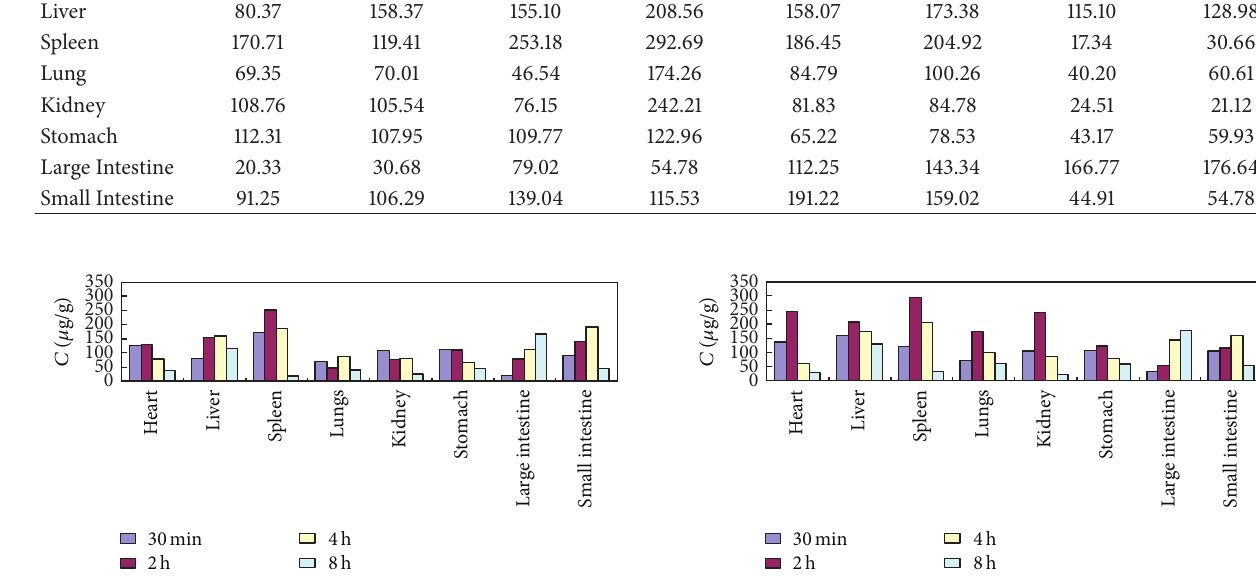
Figure 5: The concentration-time profile of (4 E ,6 E ,12 E )- tetradecatriene-8,10-diyne-1,3-diyl diacetate in tissues after oral administration of raw Atractylodis Rhizoma at a dose of 40 g ⋅ kg −1 to rats ( 𝑛 = 6 ).